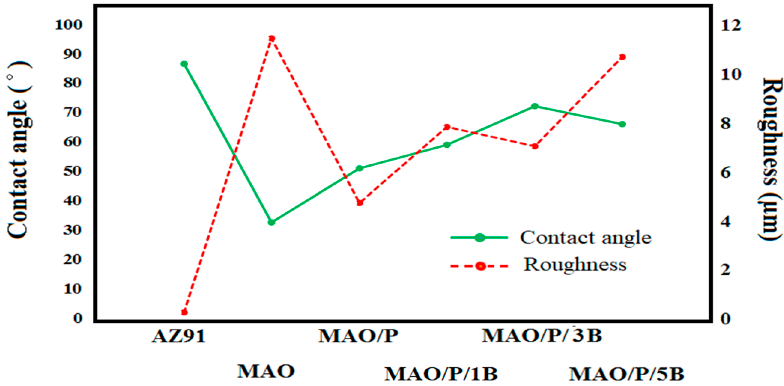
Figure 6. The average surface roughness and wettability of modified and unmodified samples.